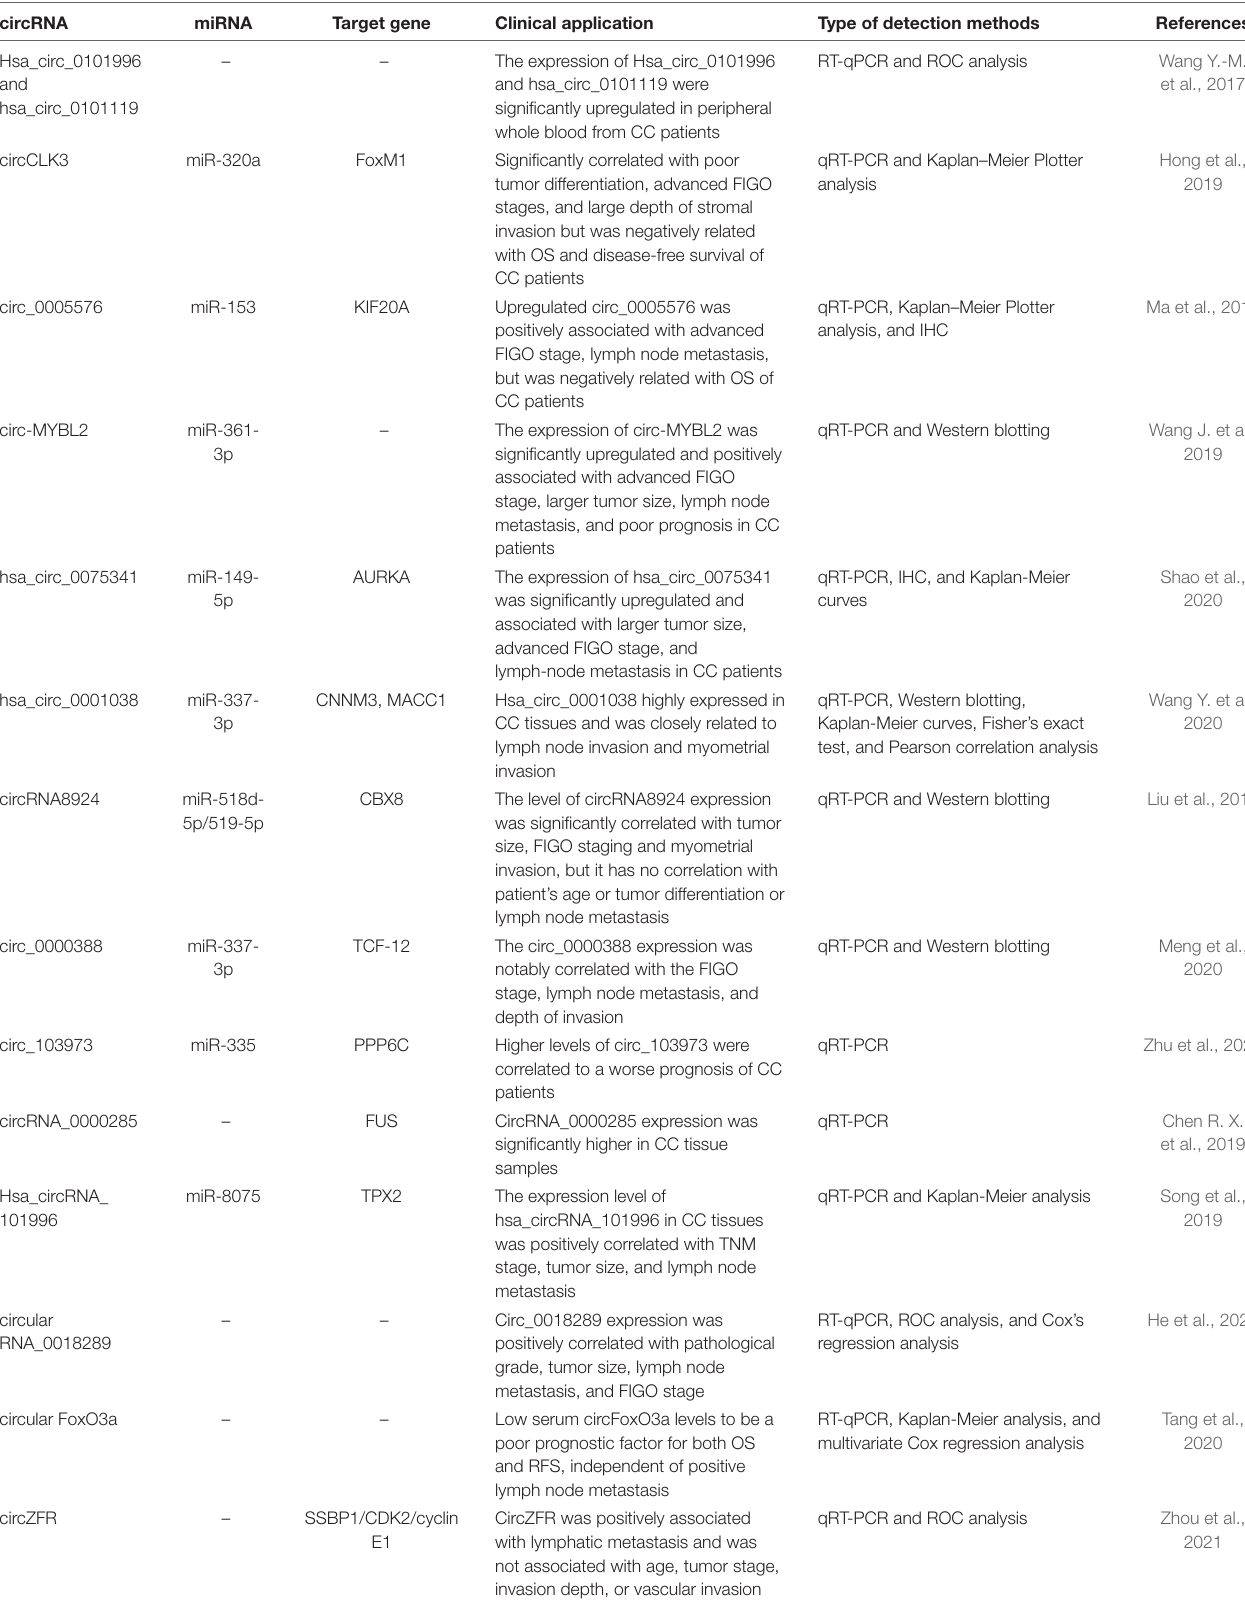
TABLE 2 | The potential circRNAs that could be used as biomarkers in clinical